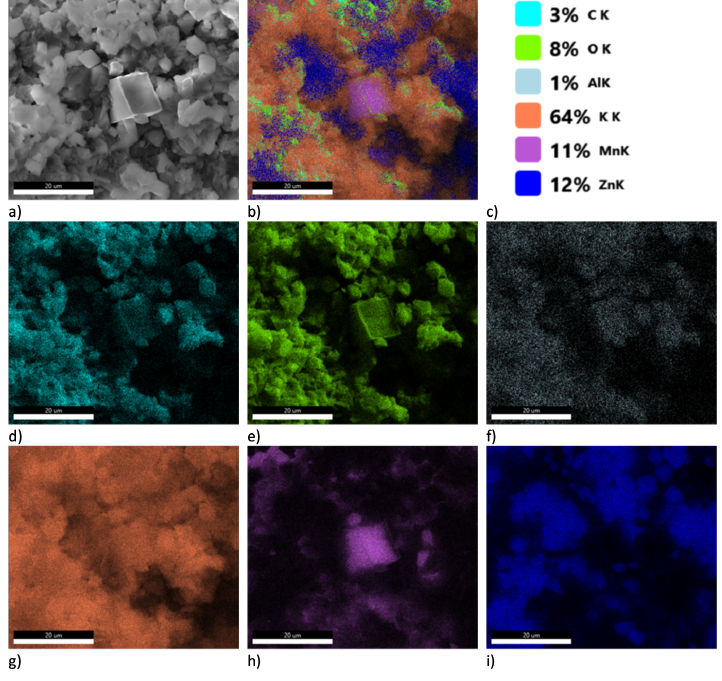
Figure A2. Result of SEM-EDS analysis for sample Zn2. ( a )—SEM picture; ( b )—EDS map; ( c )— weight concentration %; ( d )—EDS map for C; ( e )—EDS map for O; ( f )—EDS map for Al; ( g )—EDS map for K; ( h )—EDS map for Mn; ( i )—EDS map for